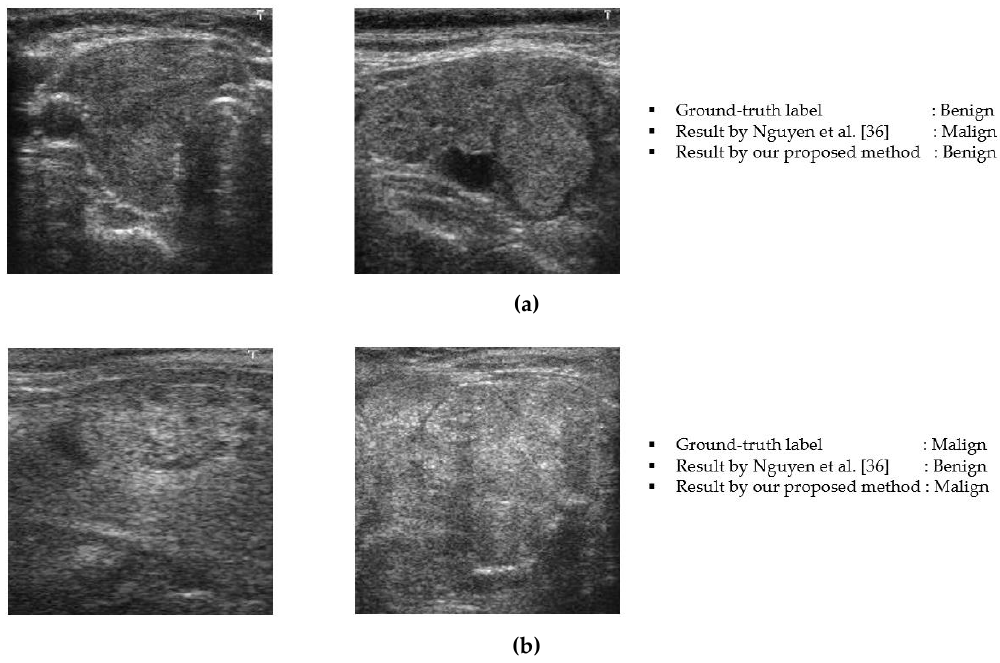
Figure 9. Example results obtained by our proposed method: (a) example results of the benign case and (b) example results of the malign case.